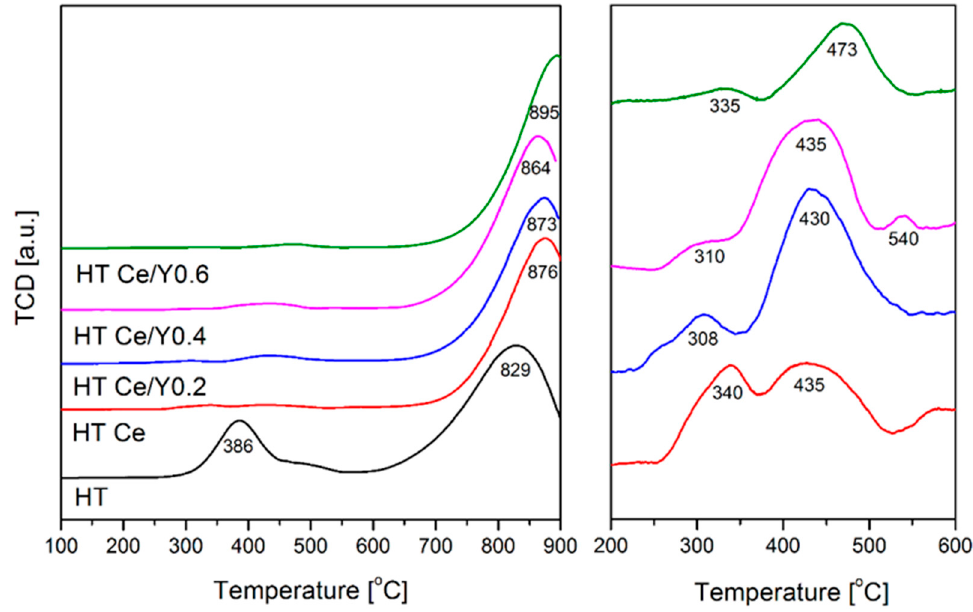
Figure 2. Temperature-programmed reduction (TPR-H 2 ) profiles recorded for Ce- and Y-modified catalysts. H 2 consumption was recorded with the aid of a thermal conductivity detector (TCD).